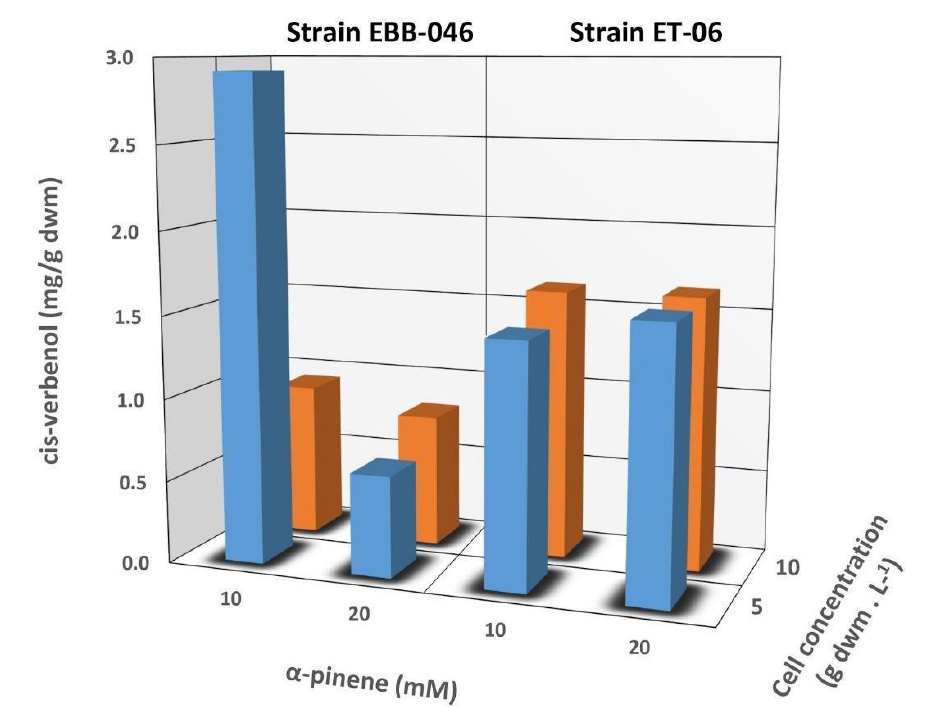
Figure 3. The influence exerted by the concentration of α -pinene (10 and 20 mM) and the mycelium (5 and 10 g/L) on the cis -Verbenol yield during biotransformation reactions using whole cells of the EBB-046 and ET-06 strains of Trametes elegans . The incubation time was 48